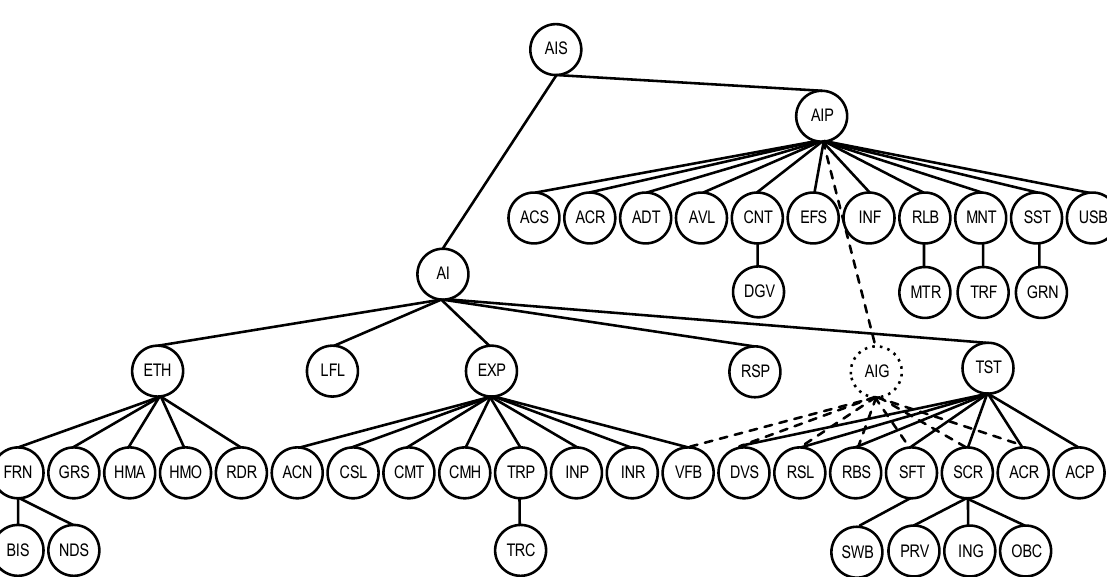
Figure 6. The graph representation of the AI system quality model 𝑄𝑆 𝐶ℎ𝐴𝐼𝑆 .